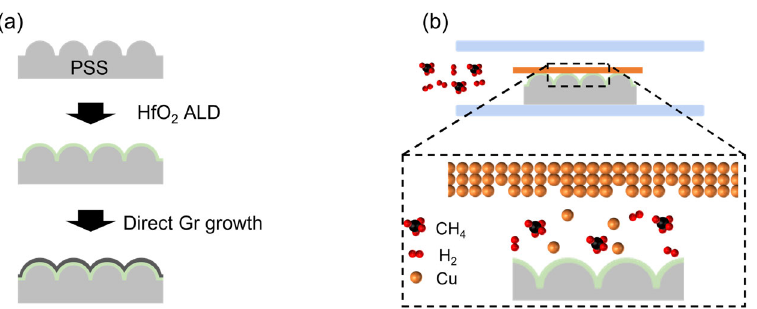
Figure 1. Schematic of direct growth of transferable 3D Gr on TSL ‐ deposited PSS. ( a ) Fabrication process for transferable 3D Gr and ( b ) growth mechanism of Cu ‐ vapor ‐ assisted Gr.